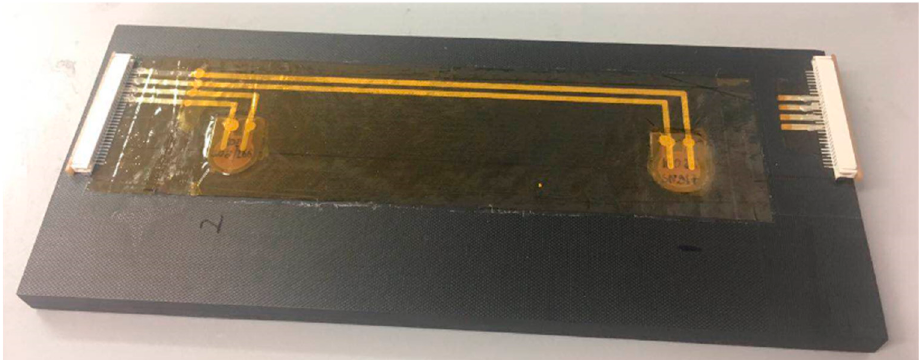
Figure 5. Surface ‐ mounted diagnostic layer.